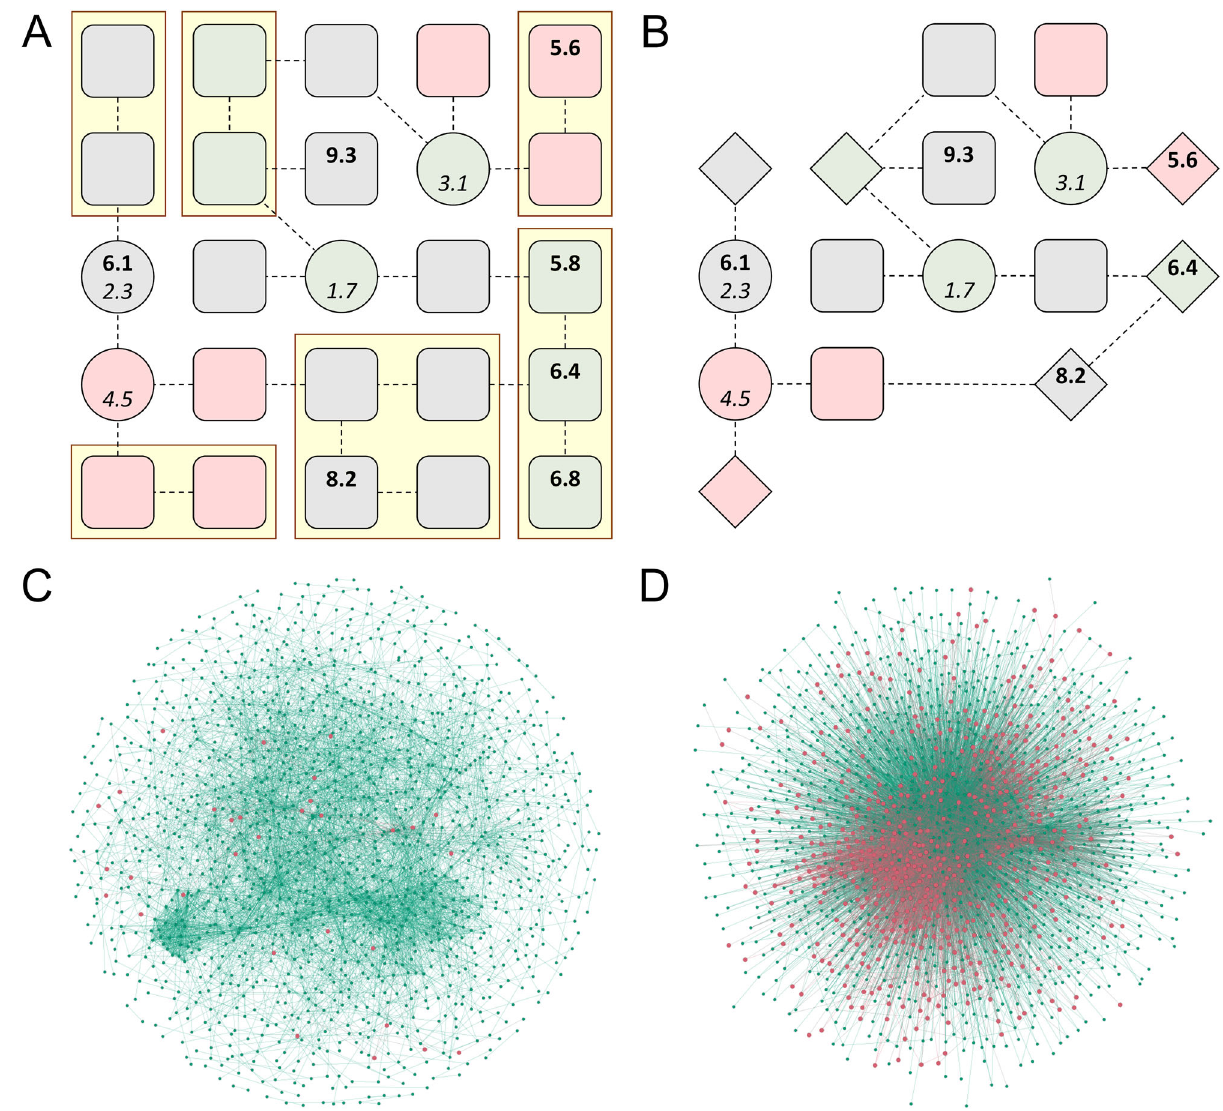
Fig. 3 Graph reduction of cancer-speci fi c networks. A A schematic of the initial graph with yellow boxes outlining groups of nodes that can be merged by contracting their edges. B A schematic graph of the reduced graph in which merged nodes are represented by diamonds. C The initial (sub)network for glioblastoma (cell line A172) with red nodes representing kinases and green nodes representing other proteins. D The reduced network for glioblastoma colored the same as in ( C ). The network in ( C ) is a randomly sampled subgraph from the original network with the same number of nodes as ( D using cancer cell lines from one tissue as a validation set while the remaining cancer cell lines were used for model training. Since cell lines collected from different tissues have different gene expres- sion patterns, this cross-validation scheme eliminates the overlap between training and validation data. In addition, there is also a desired feature variability on account of different gene-disease associations which depend on the cell line and tissue type. Essentially, each fold has entirely different training and validation data. Table 2 reports the cross-validated performance of matrix- and graph-based algorithms. The fi rst matrix-based approach employs a multilayer perceptron (MLP) to the differential gene expression data along with ligand embeddings. This method represents an